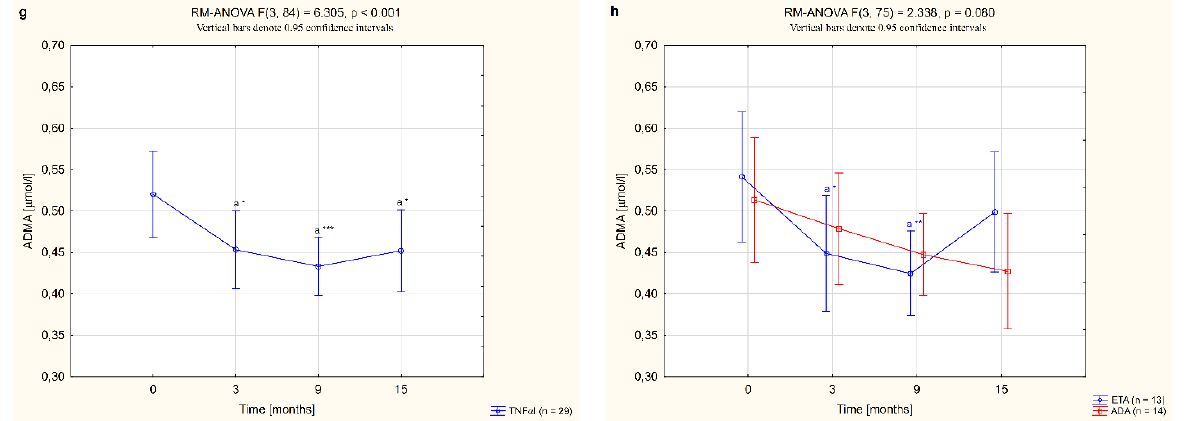
Figure 3. Changes to circulating levels of sVCAM-1 ( a , b ), MCP-1 ( c , d ), MMP-9 ( e , f ) and ADMA ( g , h ) in patients with rheumatoid arthritis during 15-month anti-TNF- α therapy and in groups divided by the type of treatment (ETA or ADA). a statistically significant differences compared to baseline; b statistically significant differences compared to 3 months after therapy; c statistically significant differences compared to 9 months after therapy. Data not normally distributed (MCP-1, MMP-9) were log-transformed before analyses. * p <0.05; ** p <0.01; *** p <0.001. ADA, adalimumab; ADMA, asymmetric dimethylarginine; ETA, etanercept; MCP-1, monocyte chemoattractant protein 1; MMP-9, matrix metalloproteinase 9; sVCAM-1, soluble of vascular cell adhesion molecule 1; TNF- α , tumor necrosis factor- α .